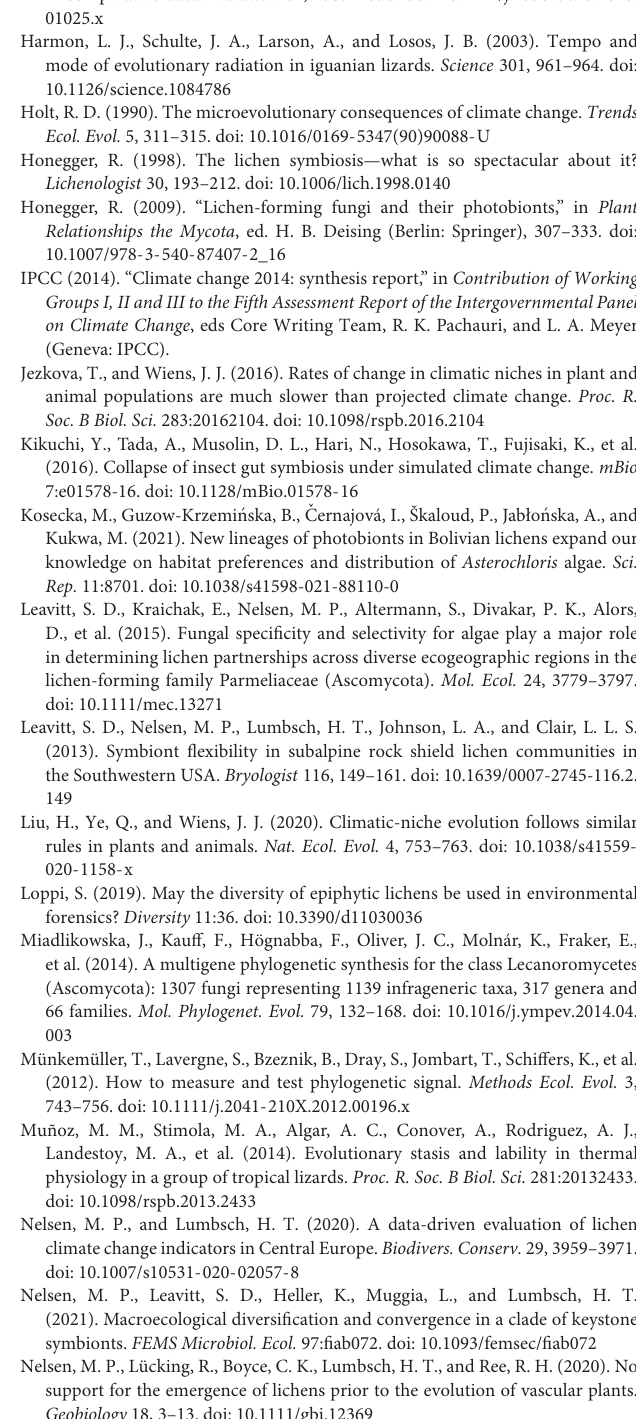
95% confidence interval derived from simulated data. The MDI value and its associated p -value are provided. Vertical shading indicates geologic periods, which are abbreviated at the